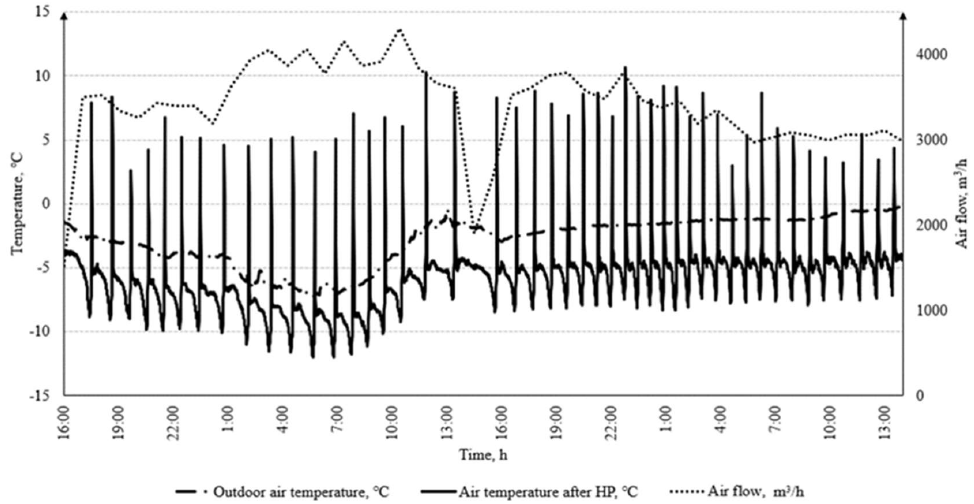
Figure 7. A comparison of the ambient air temperature with the air flow temperature after the evaporator heat exchanger and the air flow through it (1–3 December 2020).